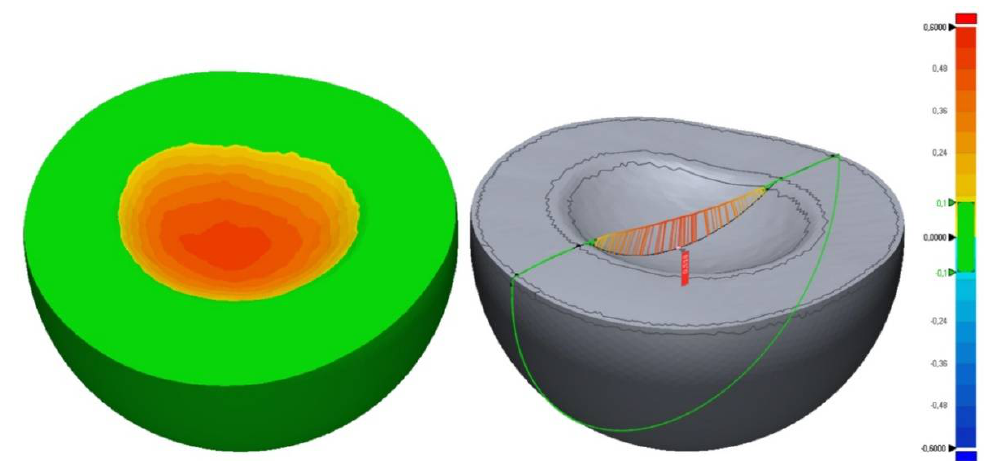
Figure 6. Exemplary scan of the 3D topography at the tooth region 15. (green: 0–100 µm, yellow: 100–240 µm, orange: 240–480 µm, and red: 480–600 µm). 100–240 µ m, orange: 240–480 µ m, and red: 480–600 µ